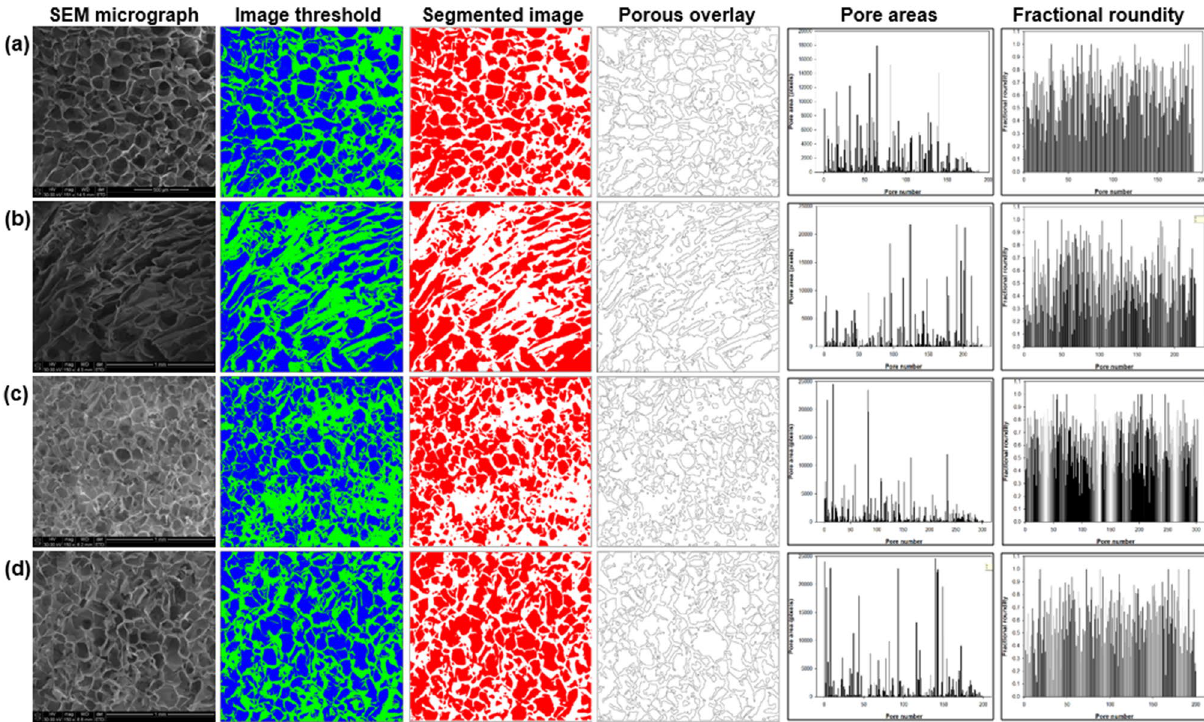
Figure 5. Image processing analysis of the porous architecture of ( a ) CHT; ( b ) CHT-mPEG; ( c ) CHT-mPEG- CHO; and ( d ) CHT-mPEG-COOH cryosponges obtained using ImageJ. Pore areas are presented as pixels (1 pixel = 1.66 µm).